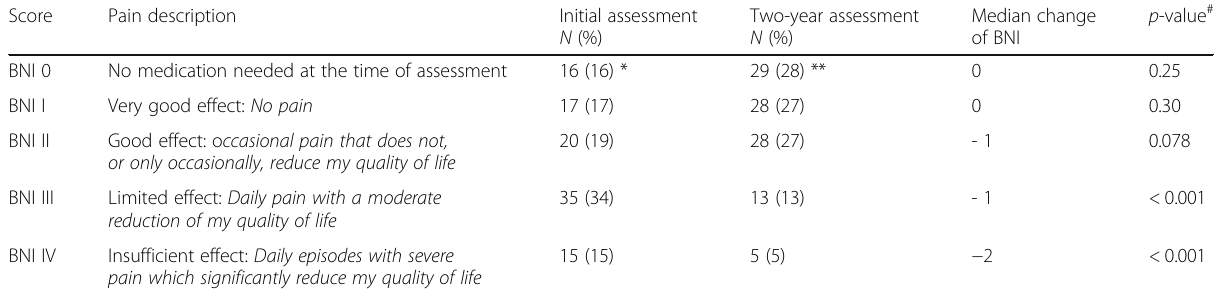
Table 3 Barrow Neurological Institute pain intensity score at baseline and at two-year assessment Score Pain